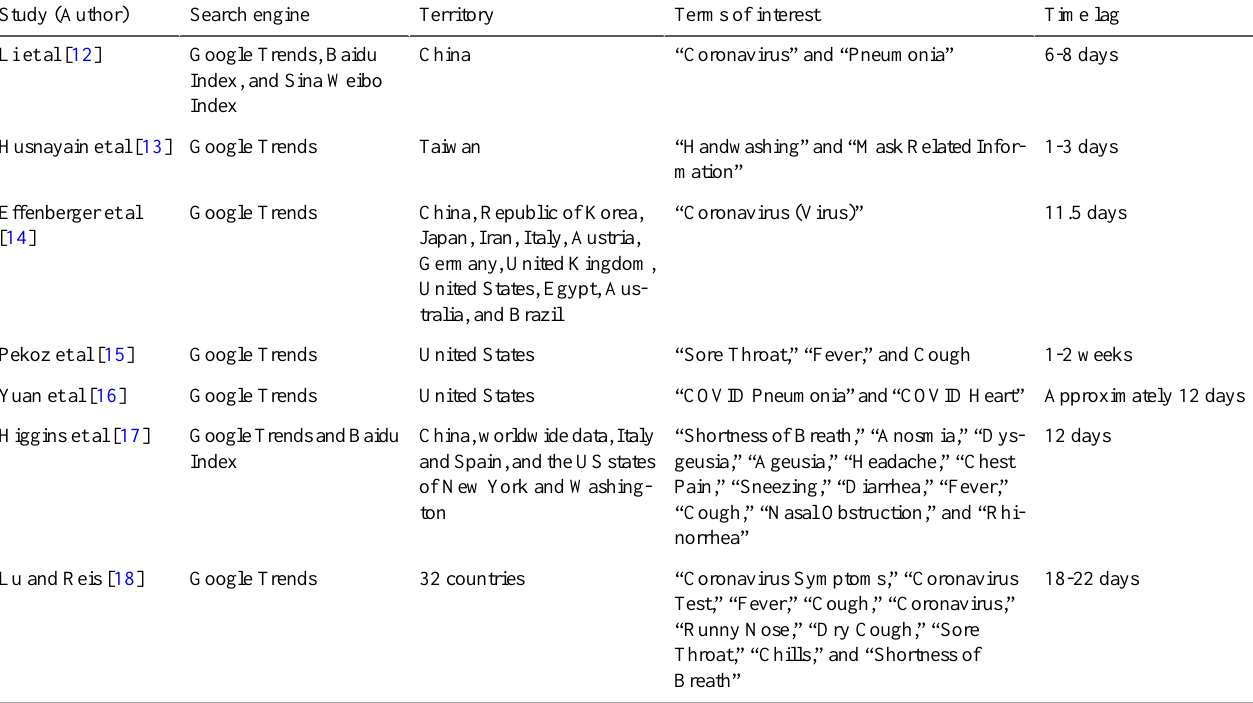
Table 1. Articles that raised the possibility of predicting the development of